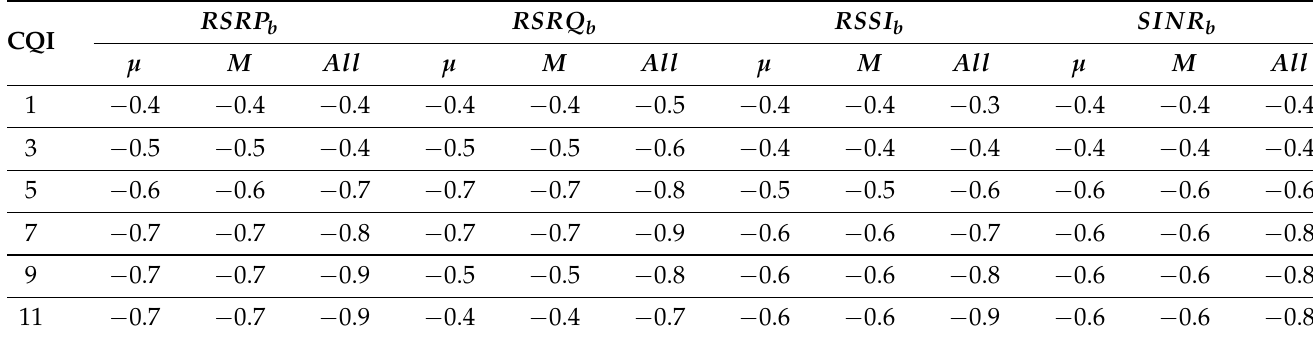
Table 2. The obtained results of the Pearson correlation coefficient for the